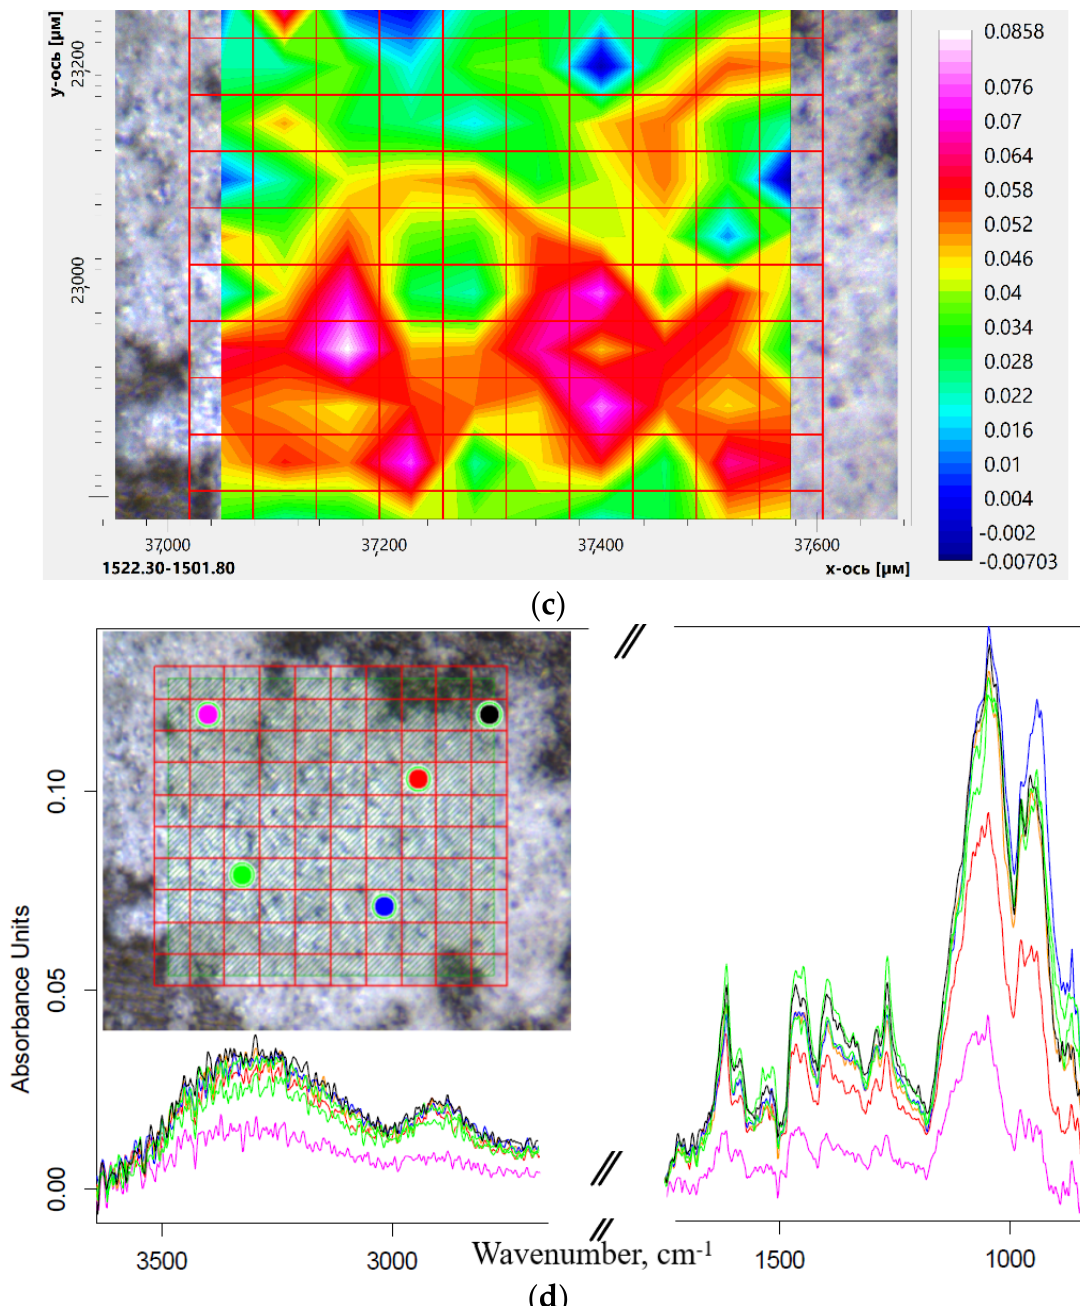
Figure 6. Integral intensity of three regions in solid phase FTIR spectra of levofloxacin (Lev) and eugenol (EG) double complex with HPCD-spermine-Man- 7 conjugate, superimposed on micropho- tography samples of 1.5 × 0.5 microns in size. ( a ) HPCD region—996–1175 cm –1 . ( b ) Levofloxacin region—1576–1636 cm –1 . ( c ) Eugenol region—1502–1522 cm –1 . ( d ) Solid phase FTIR spectra in 7 points (the same substance and region).